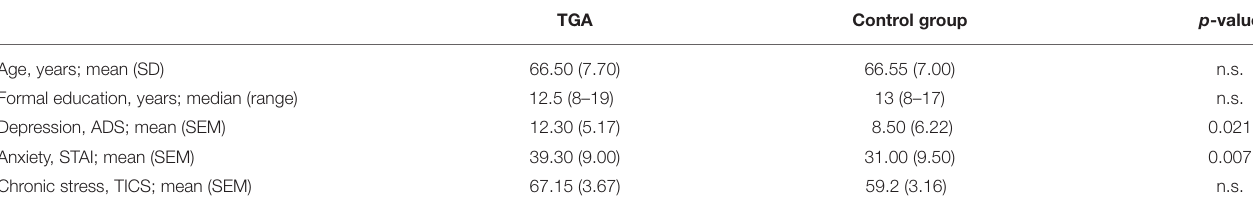
TABLE 1 | Demographic information and findings on depression, anxiety, and chronic stress.